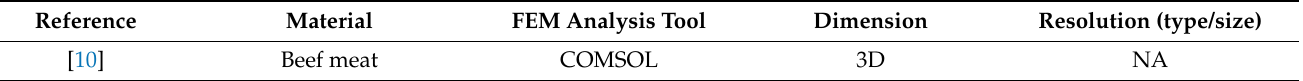
Table 2. Examples of finite element method application in food